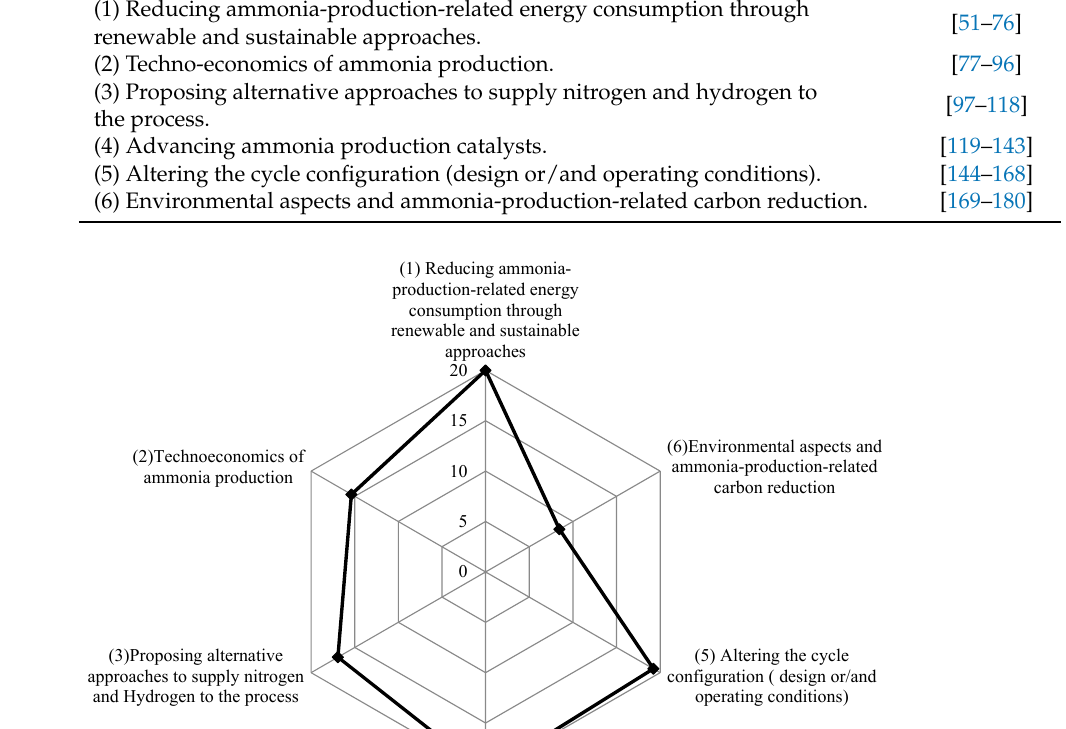
Table 6. Categories of advancing ammonia plants.